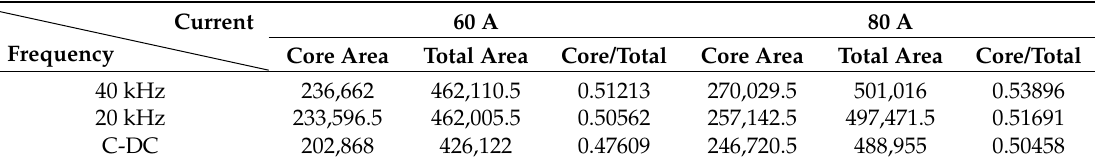
Table 1. Average data of the core region area relative value, the total area relative value, and the ratio of the core region to the total area. C-DC means conventional direct current.